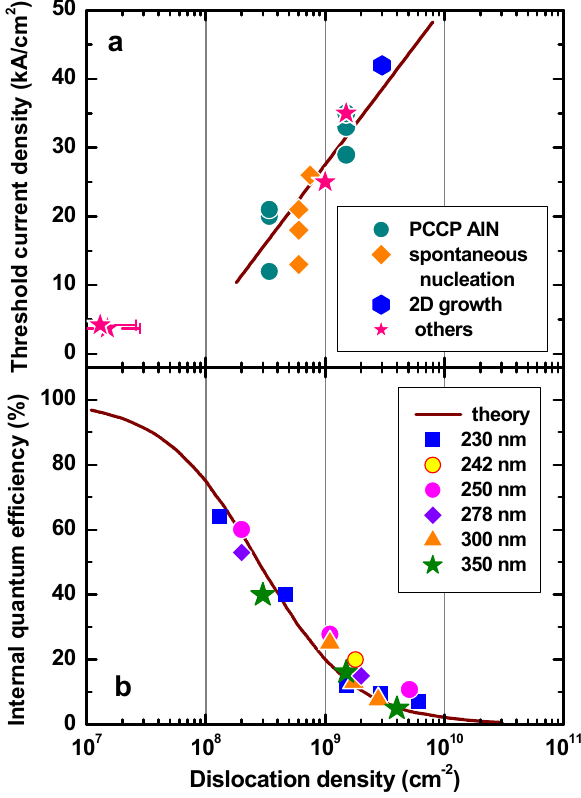
Figure 2. ( a ) Experimental threshold current densities of UV laser diodes (symbols) fabricated by various approaches, including growth on concave-convex patterned AlN (PCCP AlN) vs. TDD [25,28–30]; the straight line approximates the data. ( b ) Measured internal quantum efficiency (symbols) of UV-LEDs emitting at various wavelengths as a function of TDD in the LED structure [31–33]; the solid line is the theoretical curve calculated by the model described in [34].